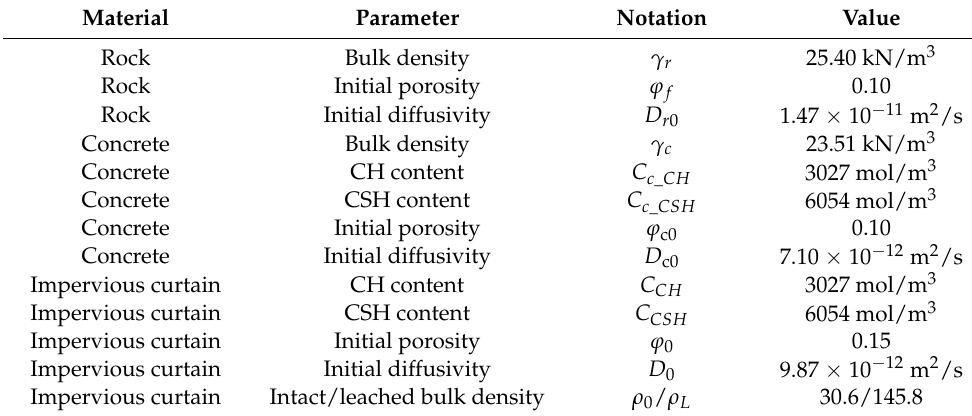
Table 2. Calculation parameters of rock and grout curtain.